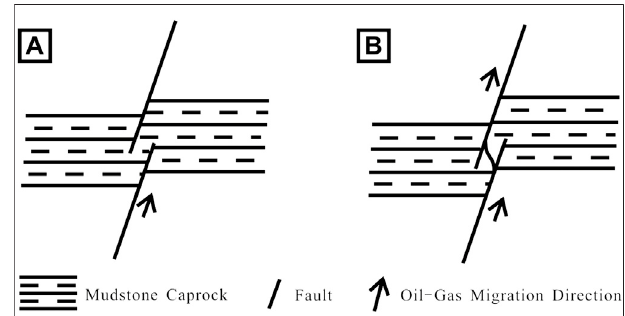
FIGURE 3 | Diagram of regional mudstone caprock damaged by fault during the hydrocarbon accumulation period. (A) Mudstone caprock not damaged by fault; (B) mudstone caprock damaged by fault.